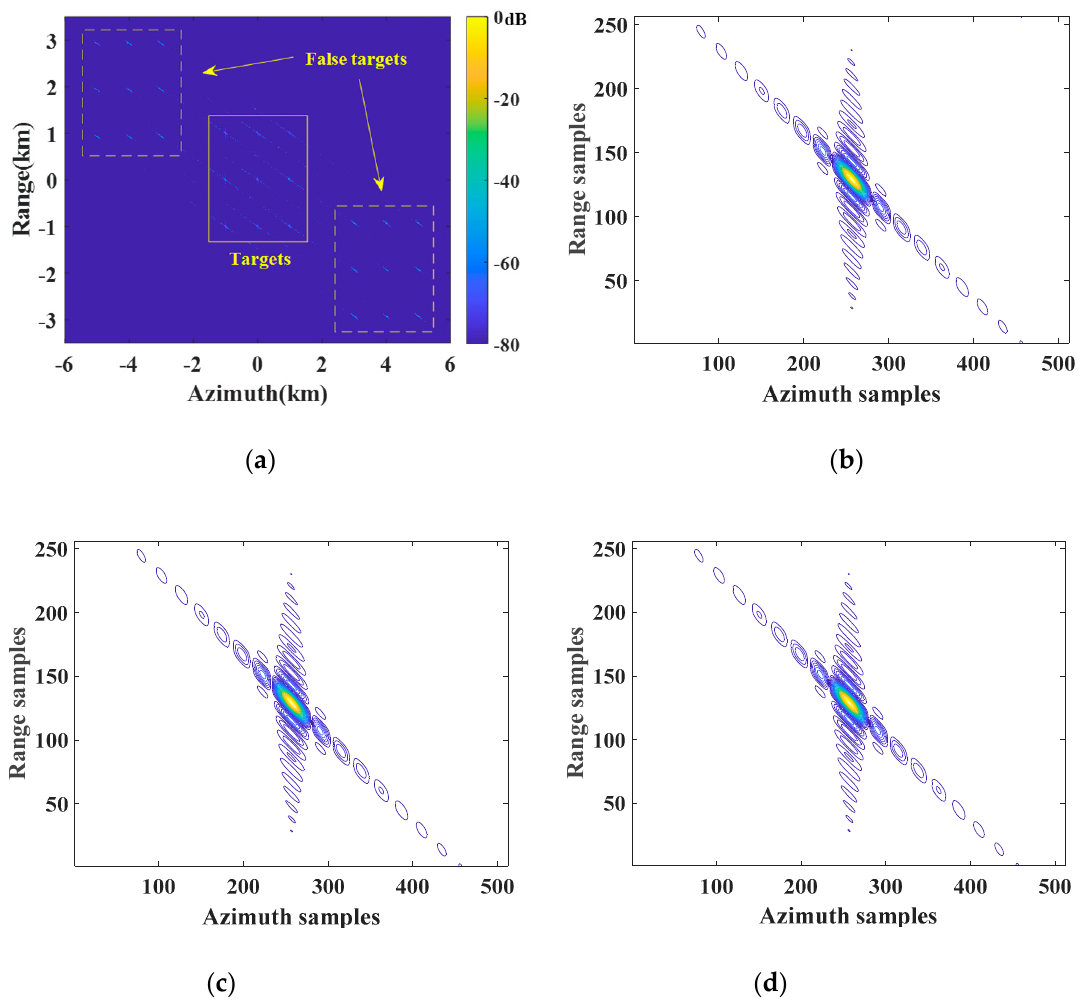
Figure 14. The designed scene with nine point-targets.